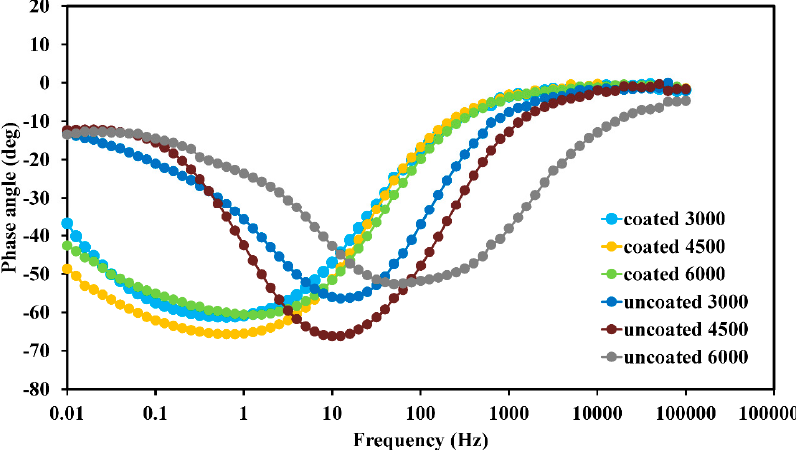
Figure 7. Bode phase plots for the Cr 3 C 2 –NiCr-coated and uncoated SS316 samples at different rotation speeds.